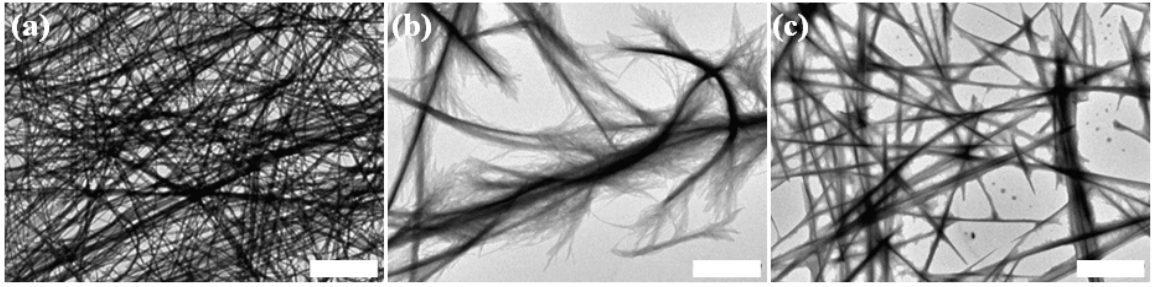
Figure 6. The ultrastructural effect of subjecting Asp-DOPA-Asn-Lys-DOPA assemblies to 37 °C. 6 mM peptide solution in water was allowed to assemble at room temperature for four days then sampled for TEM ( a ) after additional overnight incubation at room temperature or ( b ) after additional overnight incubation at 37 °C; ( c ) the same solution aliquot presented in the previous panel, sampled after 8 h recovery at room temperature. For all samples, negative staining was not applied. Scale bars represent 2 µm.